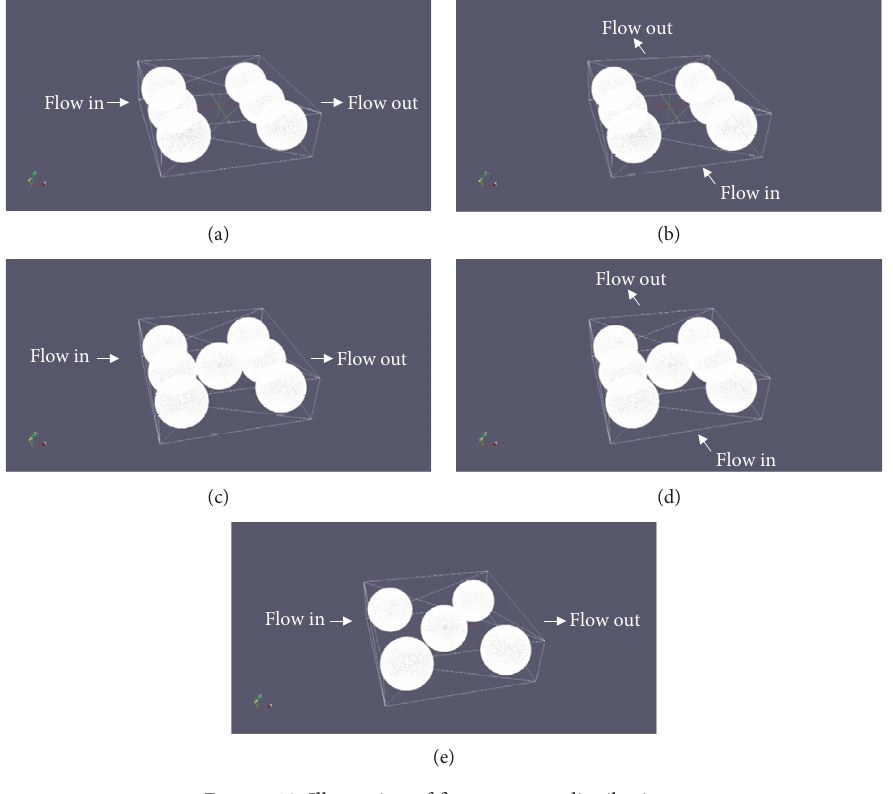
Figure 10: Illustration of fi ve proppant distributions.